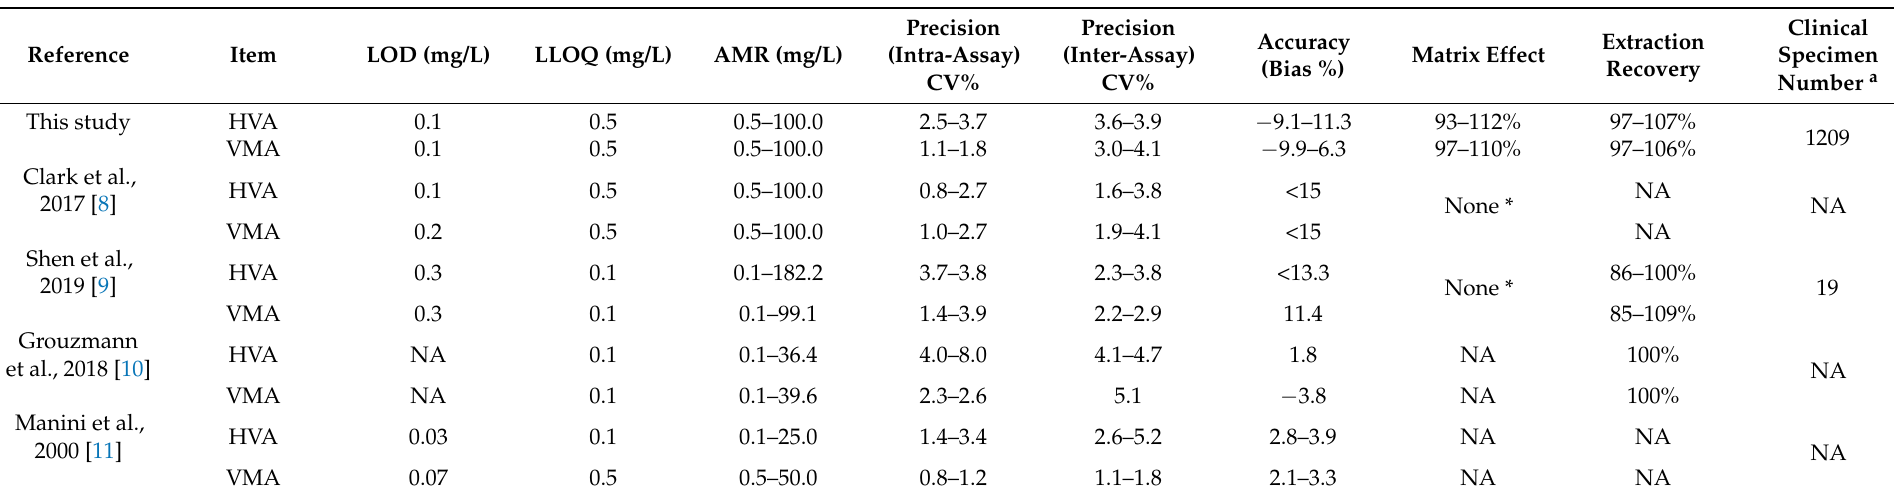
Table 1. Summary of analytical performance of LC–MS/MS methods for quantification of HVA and